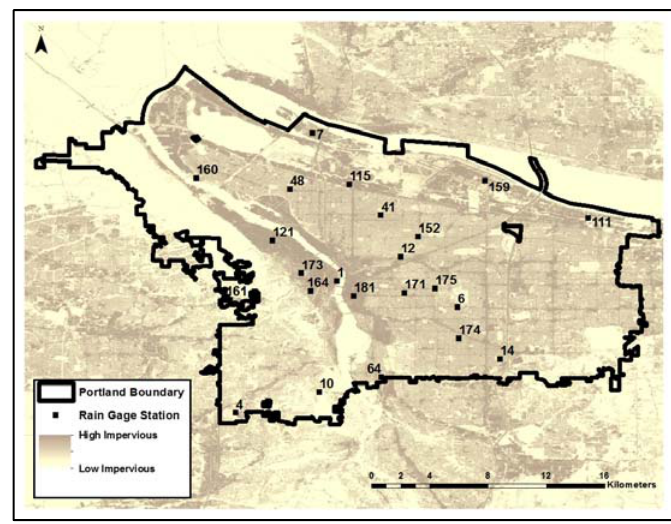
Figure 1. Location of weather stations in Portland, Oregon (OR).